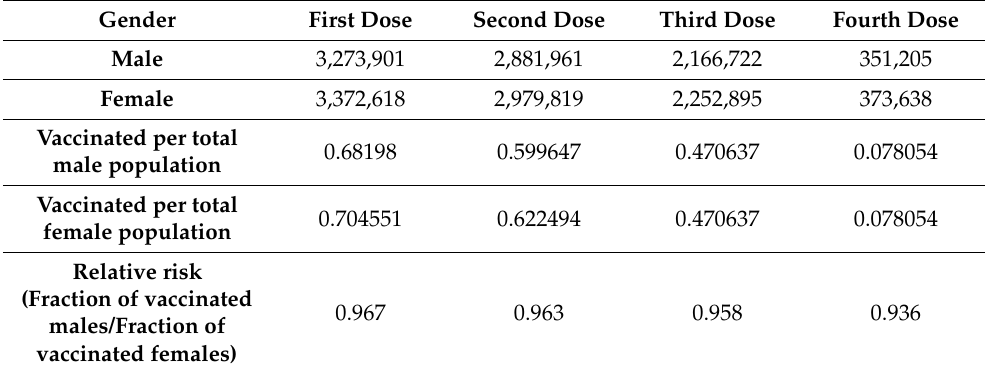
Table 2. Differences in vaccination uptake between males and females.